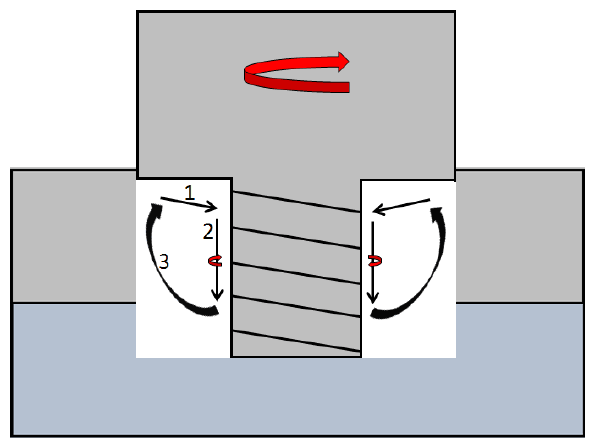
Figure 2. Schematic illustration of material flow during FSW.